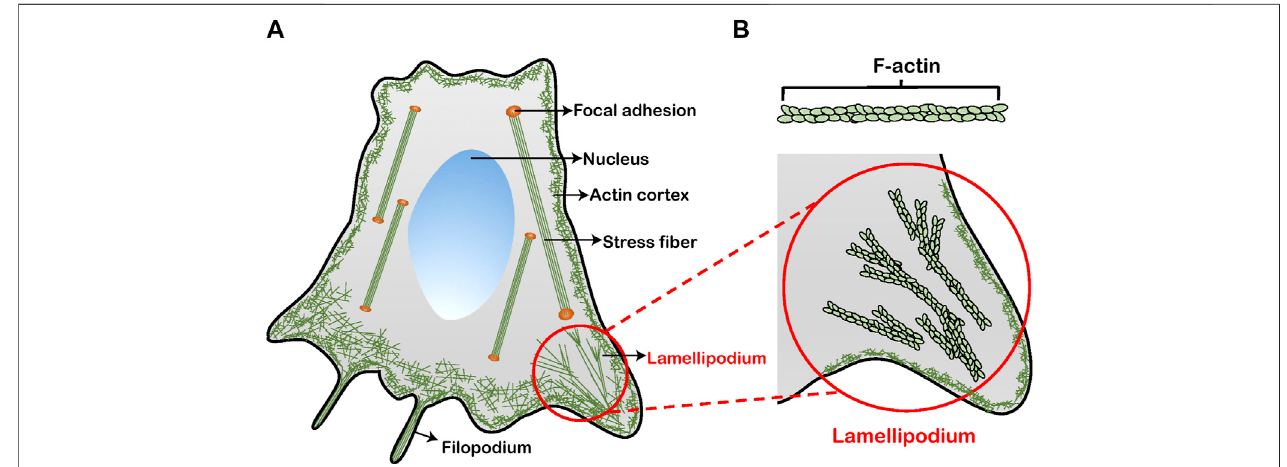
FIGURE1| SchematicsofacellwithF-actinarchitectures. (A) FourprimarytypesofF-actinstructuresinthecytoskeleton:actincortex,stress fi ber, fi lopodium,and lamellipodium. (B) A magni fi ed view of the lamellipodium. The formation of lamellipodium is facilitated by the organization of F-actin.